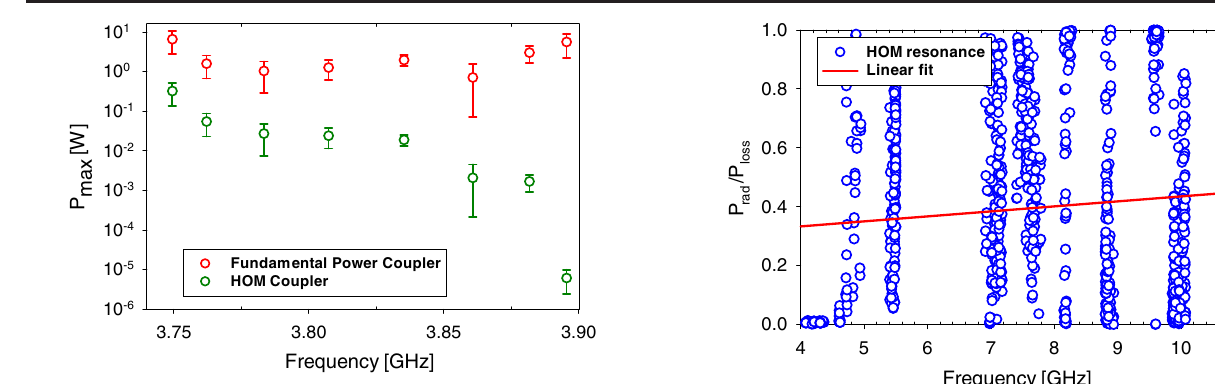
FIG. 13. Radiation of the middle cavity trapped HOMs through the left and right beam